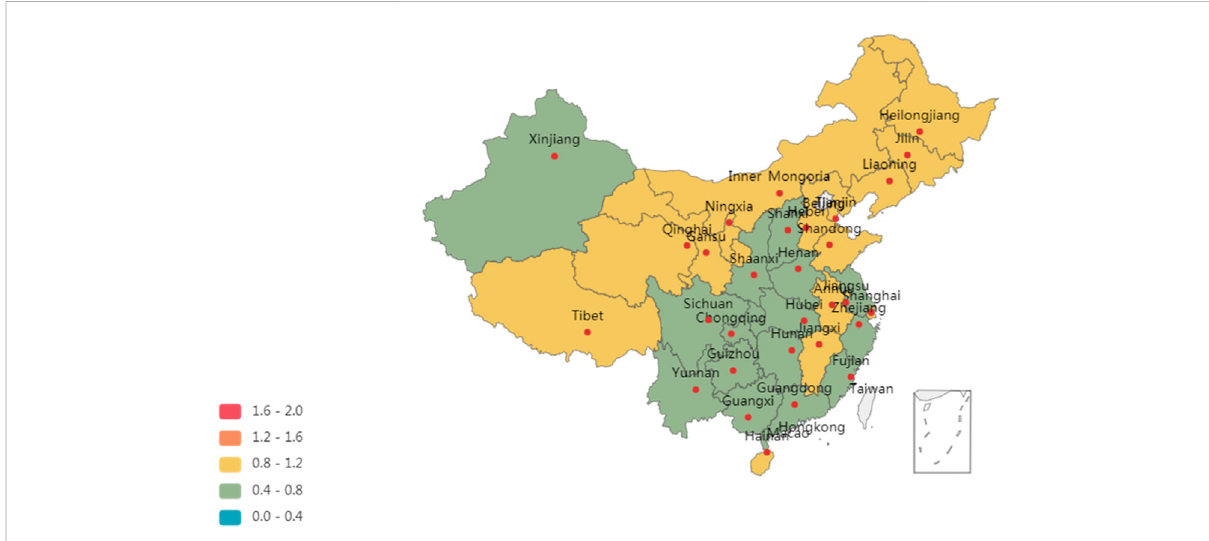
FIGURE 5 National green total factor productivity of service industry in 2015.